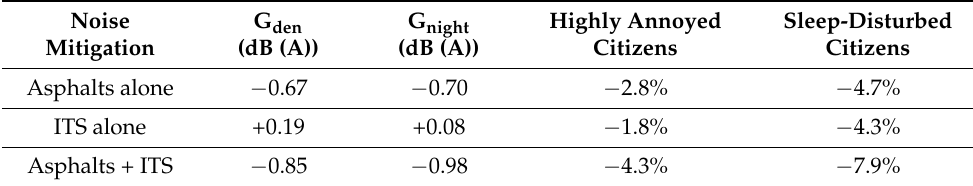
Table 4. Efficacy of the laying of three low-noise pavements, or installation of the ITS or their combination evaluated trough the difference in G den and G nigh , or the percentage differences of total citizens of Piombino highly annoyed and